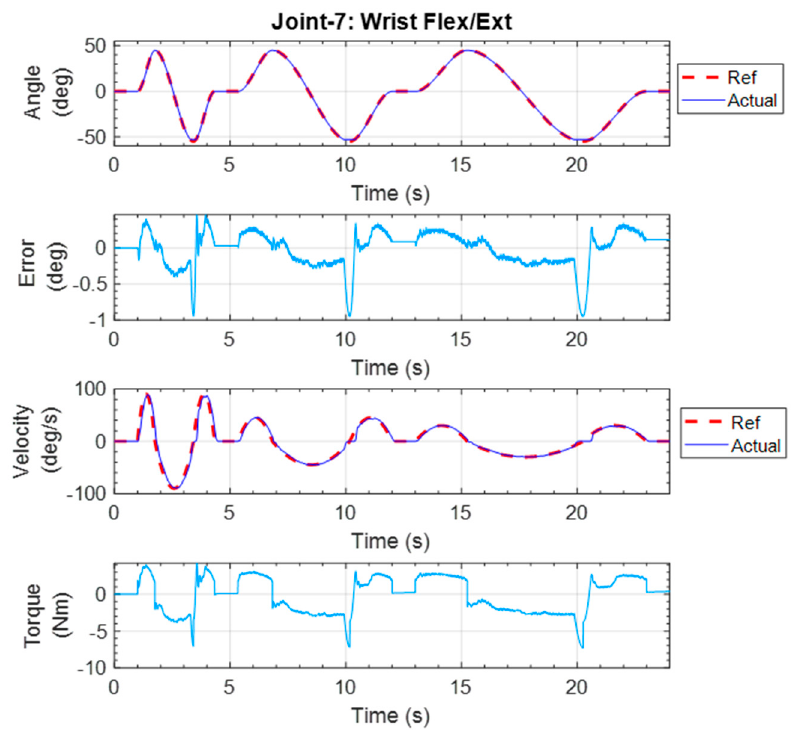
Figure 22. Individual joint exercise for wrist flexion–extension.